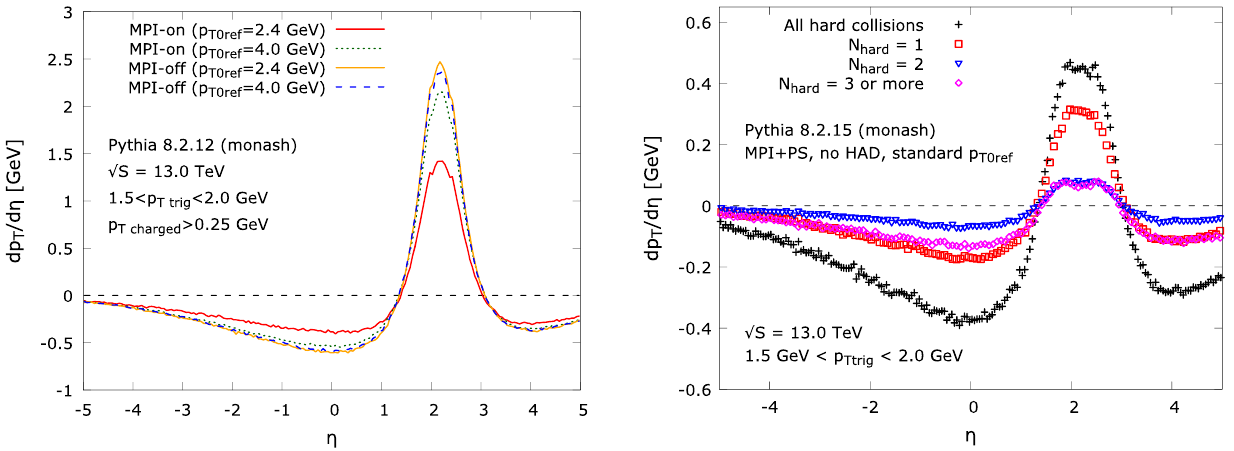
(cid:5) (cid:6) Fig. 11 p rec as a function of rapidity in Pythia with hadronization, T full beam remnant treatment, initial and final state showers. We study effect of MPI on/off in the simulation. We also change the standard parameter for the p T 0 (2 . 4GeV) cutoff in the MPI model to higher value (4 . 0GeV) to observe how this affects the distribution